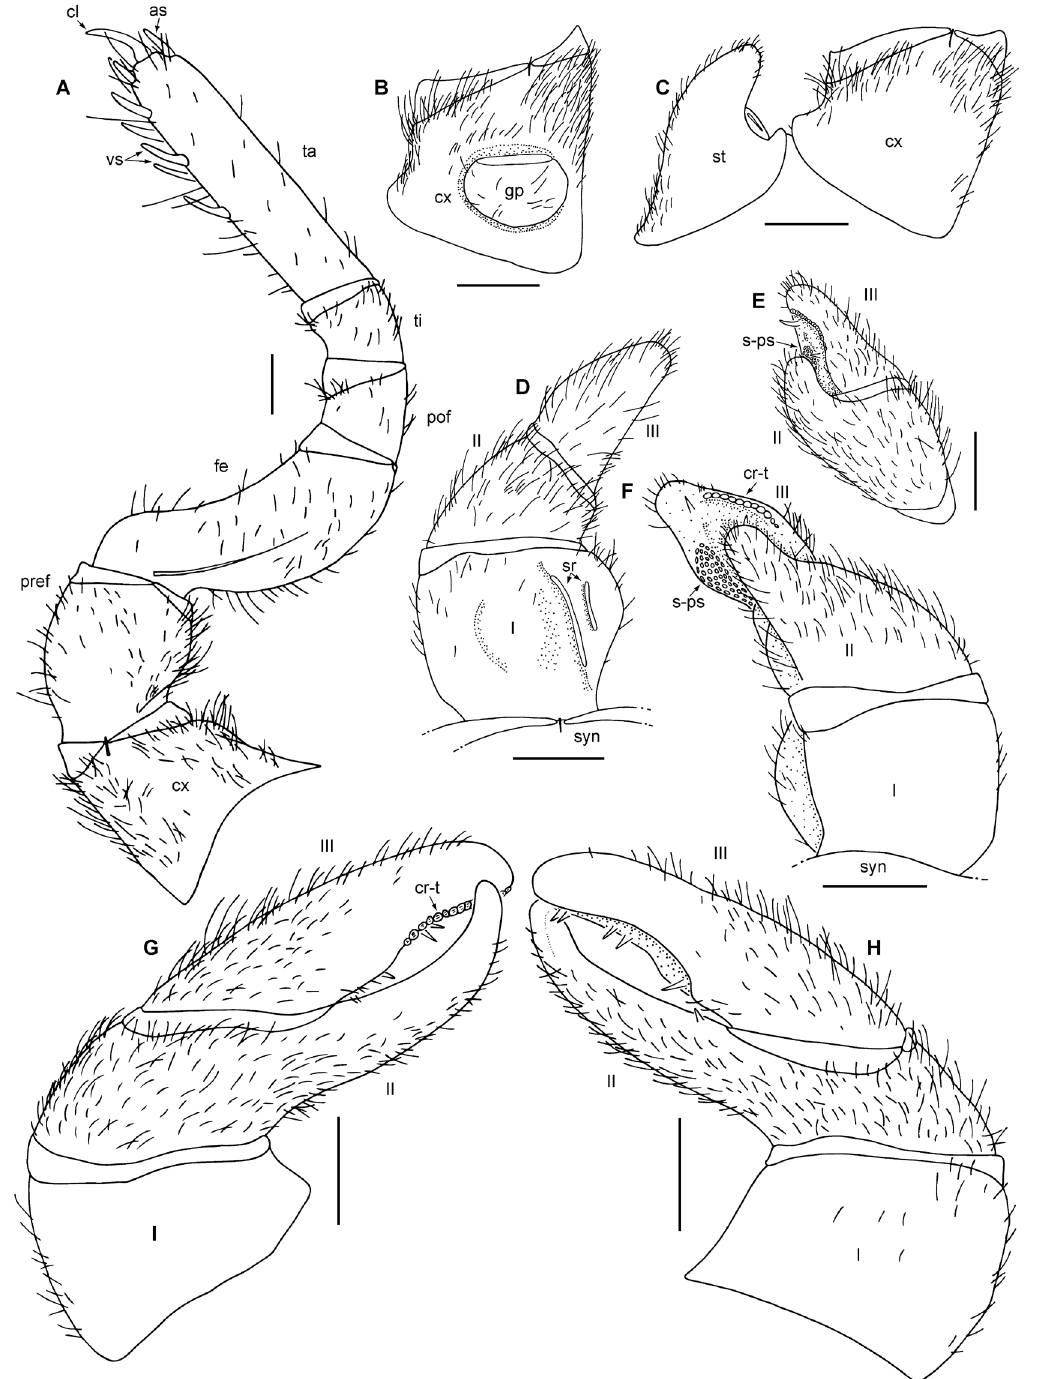
Fig. 11. Zoosphaerium masoala sp. nov., holotype (FMNH-INS 3195651). A . Left leg 9, posterior view. B . Right coxa 2 with gonopore, posterior view. C . Right coxa 1 with stigmatic plate, posterior view. D . Left anterior gonopod, anterior view. E . Left anterior gonopod, lateral view. F . Left anterior gonopod, posterior view. G . Right posterior telopod, posterior view. H . Right posterior telopod, anterior view. Abbreviations: as = apical spine; cl = claw; cr-t = crenulated teeth; cx= coxa; fe = femur; gp = gonopore; pof = postfemur; pref = prefemur; s-ps = sclerotized spots; sr = stridulation rib; st = stigmatic plate; syn = syncoxite; ta = tarsus; ti = tibia; vs = ventral spines. Roman numerals indicate telopoditomeres. Scale bars = 1